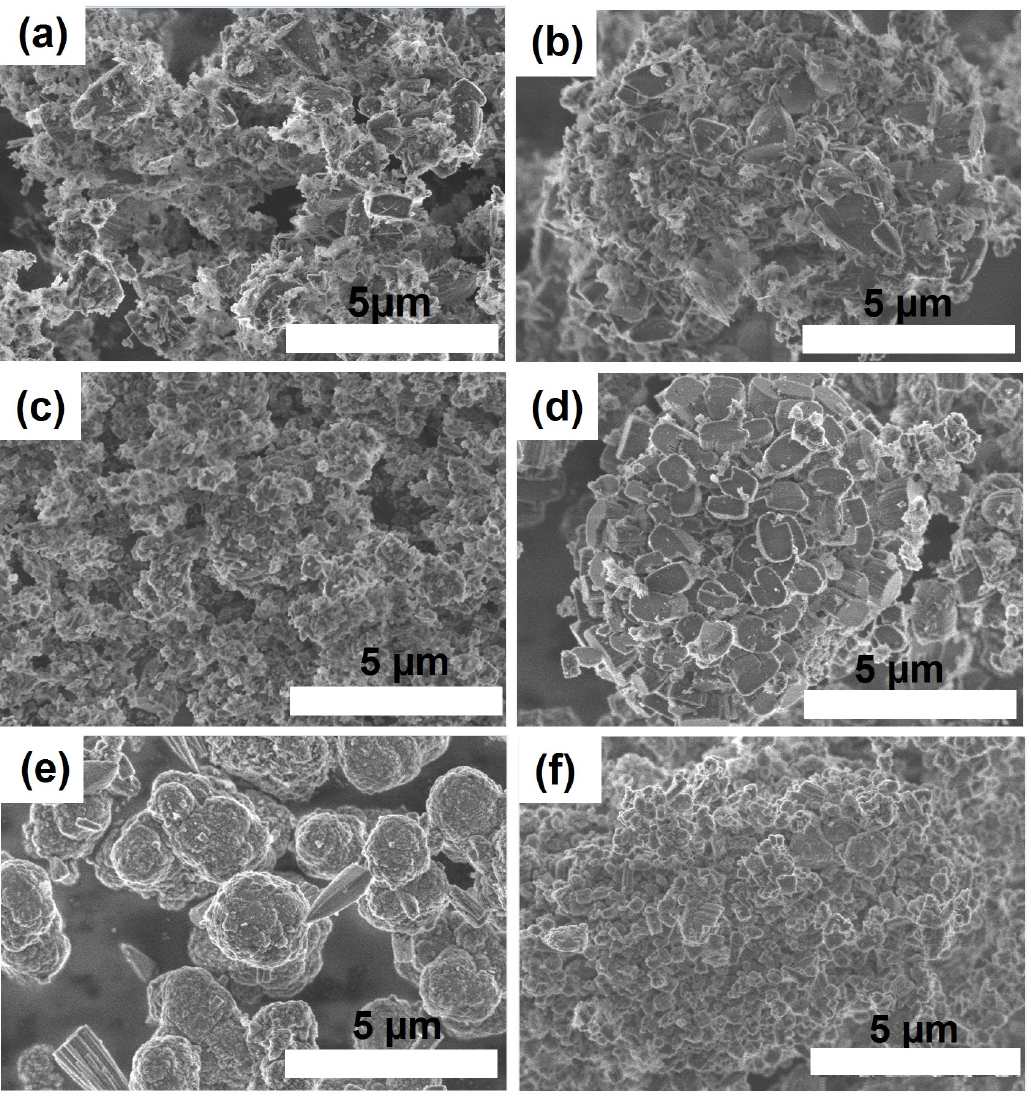
Figure 10. SEM images of crystallization products of silicoaluminophosphate gels prepared using various boehmites: ( a ) Sample SAPO-11-TR(60); ( b ) Sample SAPO-11-TR(90); ( c ) Sample SAPO-11- SB(90); ( d )-Sample SAPO-11-SB(120); ( e ) Sample SAPO-11-PR(90); ( f ) Template SAPO-11-PR(120).